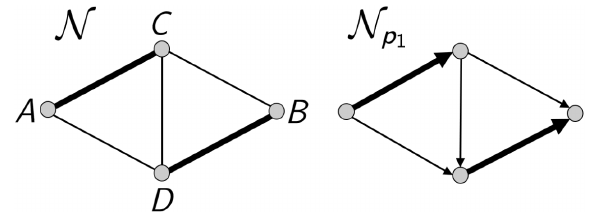
FIG. 2. A comparison of the simple graph representing the network and the directed graph representing a flooding proto- col performed on it. The left image depicts the graph of the four-user network N comprised of end users A and B and two intermediary nodes C and D . A seeks to communicate with B via a flooding protocol. The thickened lines represent higher- throughput connections between A and C and B and D . The first flooding protocol p 1 converts this graph into the directed graph N p i , which is depicted on the right. The second possible flooding protocol p 2 simply corresponds to reversing the orientation of the edge connecting C and D .